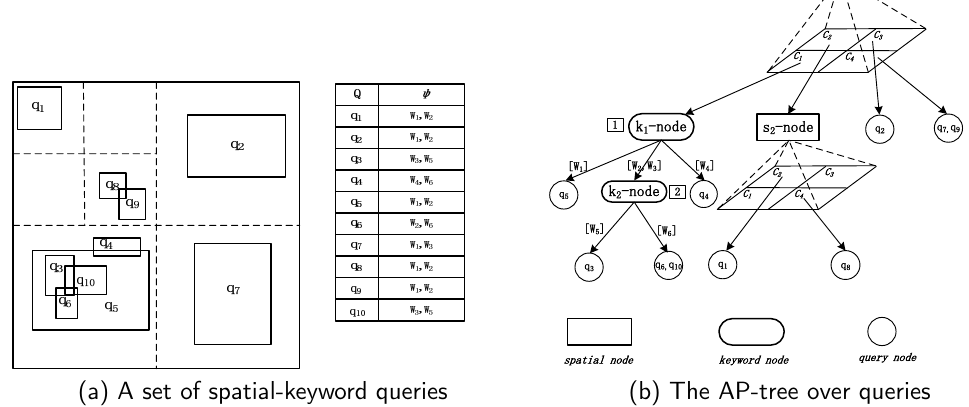
Figure 1. An example of Adaptive spatial-textual Partition